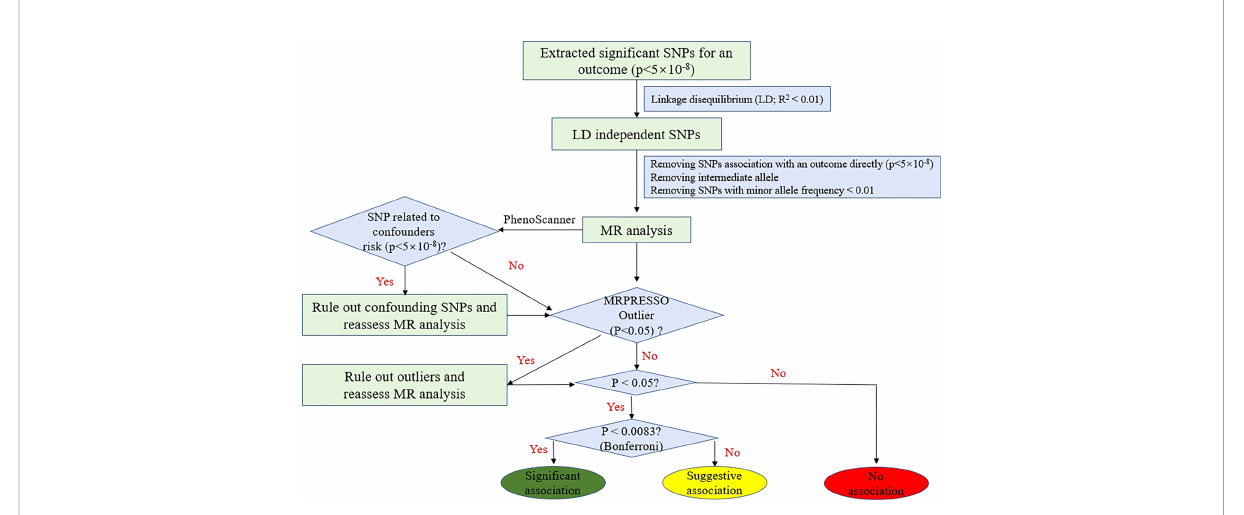
FIGURE 1 Flow chart about the analytical methods and how the MR analysis was performed step by